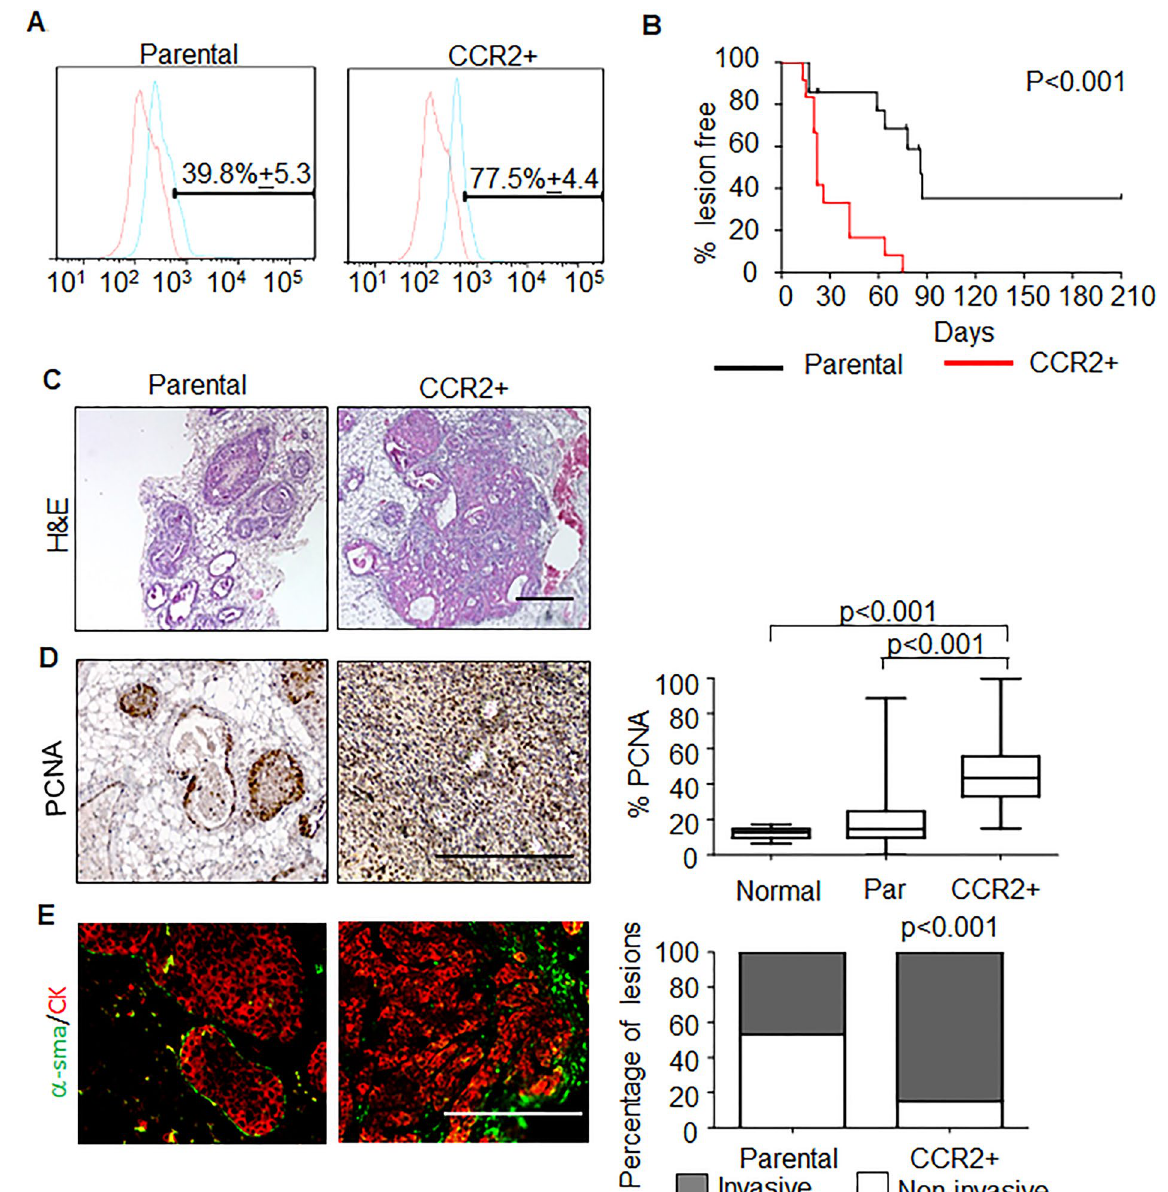
Figure 3. CCR2+ hDCIS.01 breast cancer cells show increased formation of invasive mammary lesions. ( A ) hDCIS.01 cells were magnetically sorted for CCR2 expression (CCR2+), and analyzed by flow cytometry for CCR2 expression 4 weeks post-enrichment. ( B ) Parental or CCR2+ cells were injected into the mammary ducts of NOD-SCID mice. Mice were palpated for tumor formation twice weekly. Tumor formation was plotted as a function of percent tumor free over time. Parental n = 14, CCR2+ n = 12. ( C ) H&E stain of mammary lesions from matching CCR2+ lesions and parental control harvested 75 days post-injection. ( D ) Cell proliferation was analyzed by PCNA immunostaining, normalized to hematoxylin staining. Whisker box plots are shown. Whiskers indicate min and max values. Box indicates upper and lower quartile range. Line indicates median. ( E ) Invasiveness was scored for lesions co-stained for α-sma/CK5/19. Statistical analysis was performed using Log Rank (Mantel-Cox) Test ( B ), One Way ANOVA with Bonferroni post-hoc comparison ( D ) or Chi Square test ( E ). Statistical significance was determined by p < 0.05. Scale bar = 200 Fig. S9A). INCB3284 treatment also inhibited CCL2-mediated spheroid growth of CCR2-H SUM225 cells, sup- porting the effects of CCR2 inhibition (Supplementary Fig. S9B). INCB3284 treatment inhibited CCL2-induced phosphorylation of SMAD3 and p42/44MAPK and decreased the overall protein levels of p42/44MAPK in both cell lines (Supplementary Fig. S9C,D; full-length blots shown in Supplementary Figs. S10 and S11). Overall, these studies demonstrate that CCR2 antagonists impair CCL2/CCR2 mediated growth and signaling of breast cancer cells in vitro.